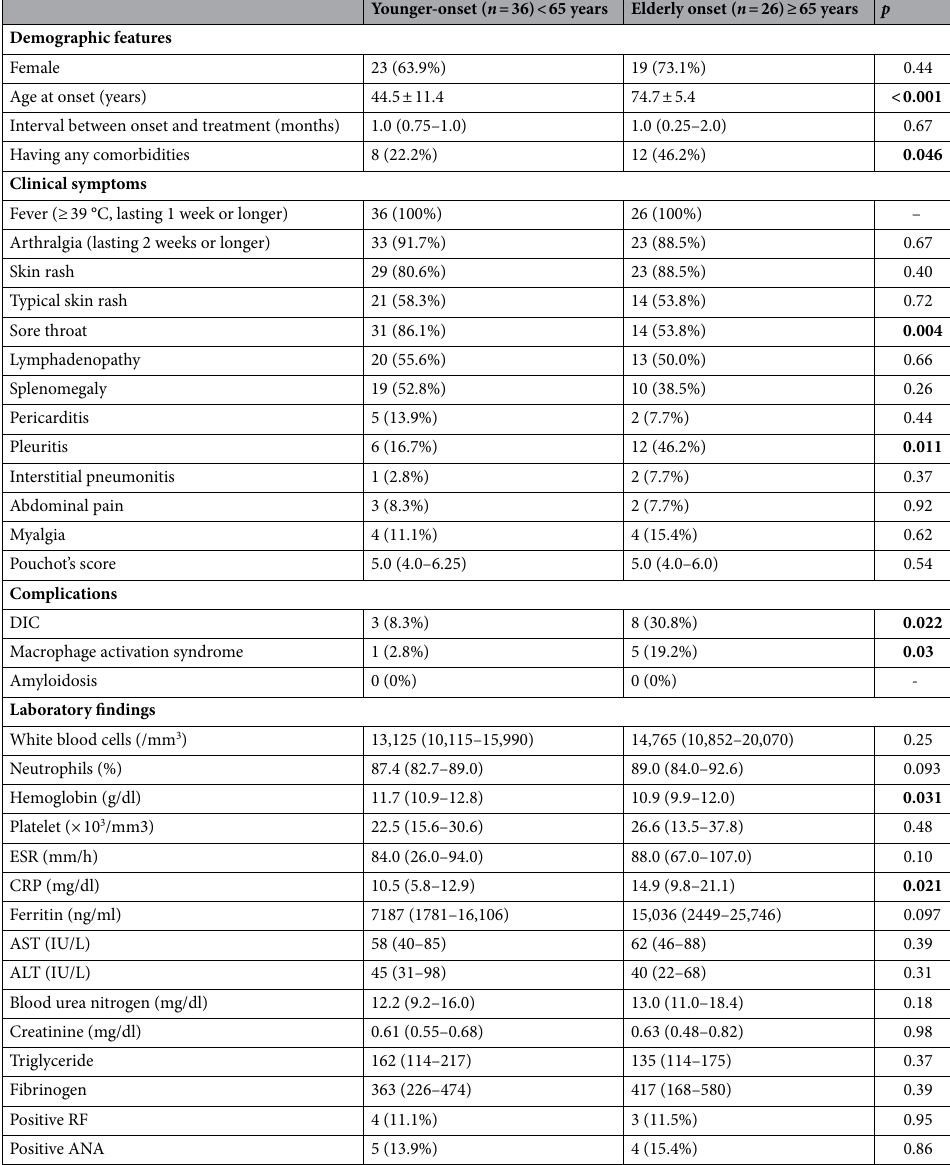
Table 1. Clinical features of patients with adult-onset Still’s disease by age group. Data are presented as number (%), mean ± standard deviation or median (interquartile range). p < 0.05, are represented in bold.